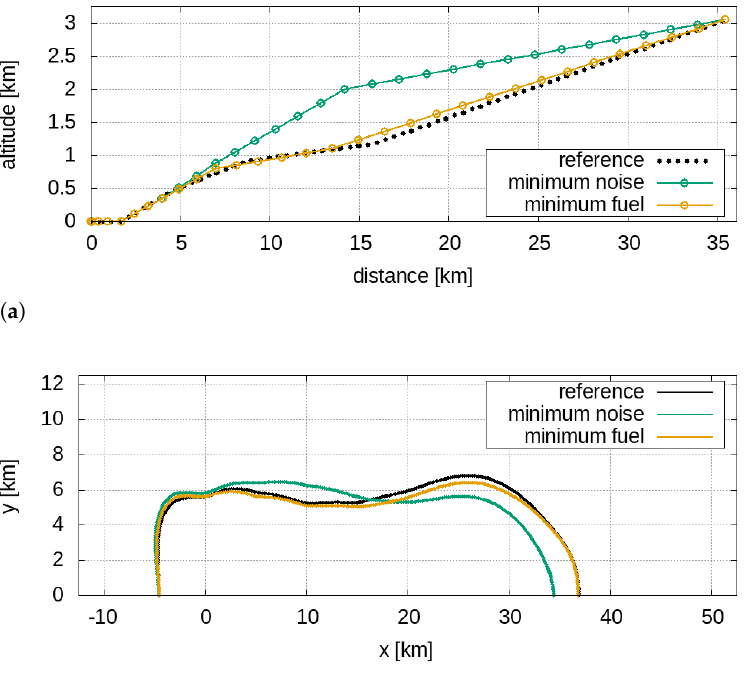
Figure 5. Takeoff manoeuvre for the single-aisle aircraft: flight paths and 60 dBA contours for the reference trajectory and the optimal solutions related to the minimum noise and the minimum fuel consumption: